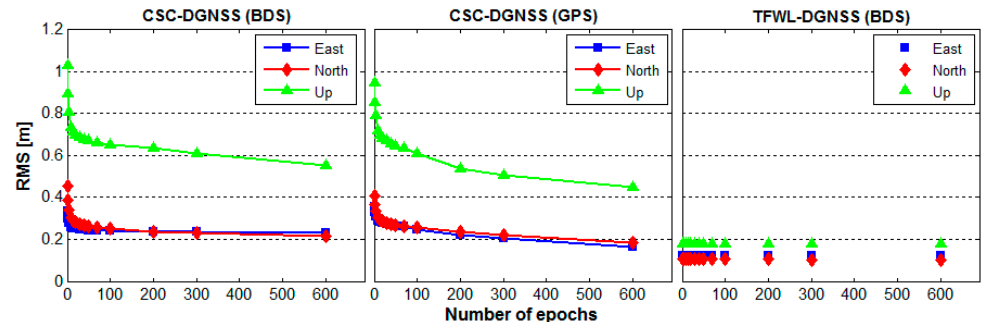
Figure 9. Positioning accuracy versus time for CSC-DGNSS and TFWL-DGNSS. The left panel is for CSC-DGNSS results derived from BDS observations, the middle panel is for CSC-DGNSS results derived from GPS observations whereas the right panel is for TFWL-DGNSS results derived from BDS observations.